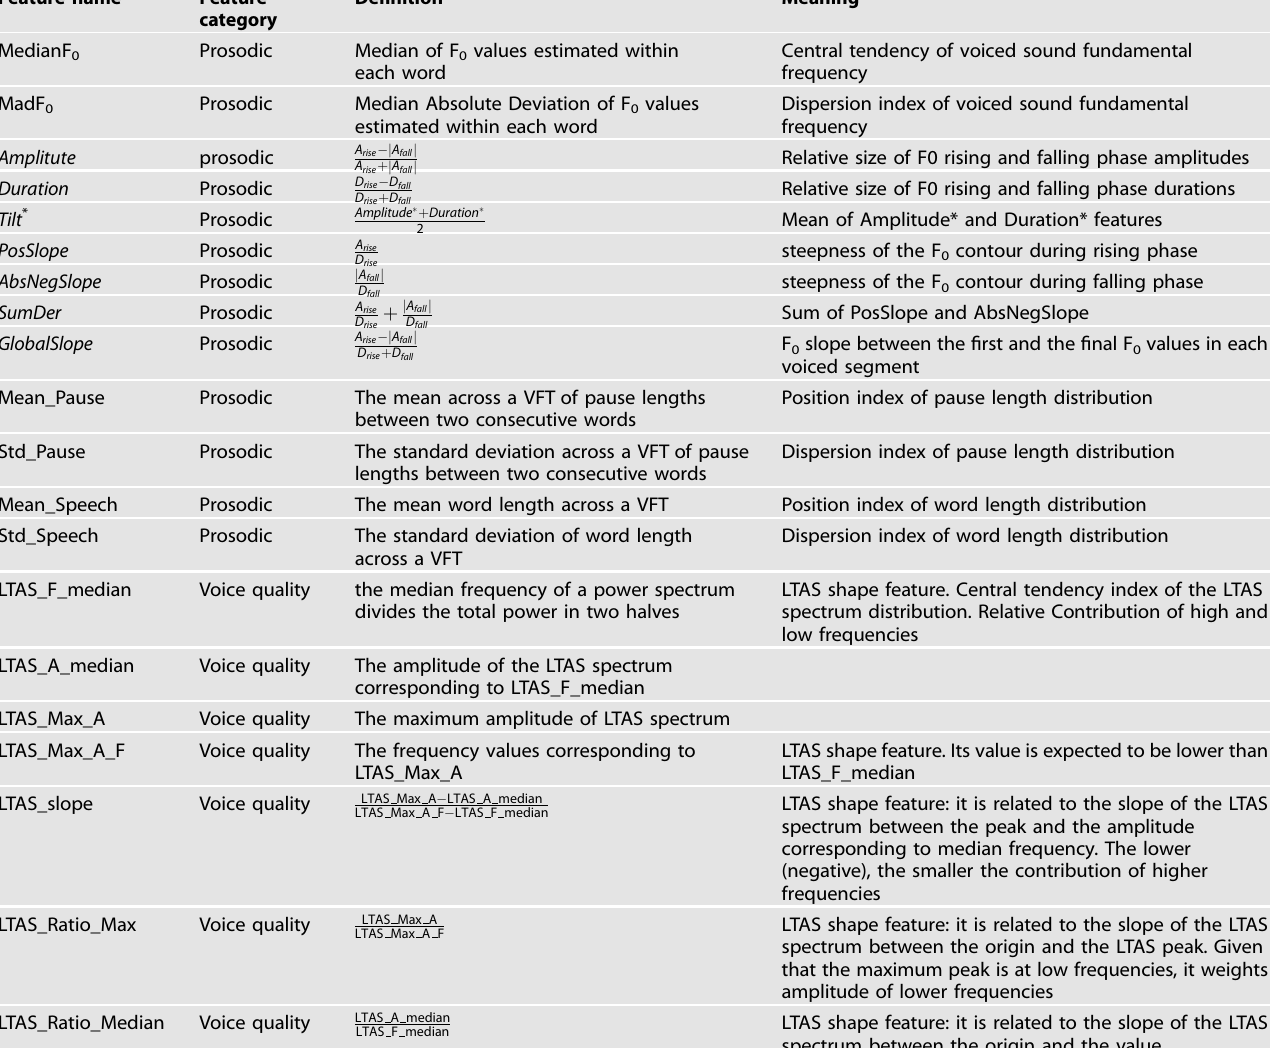
Table 2. Features used for the analysis of speech